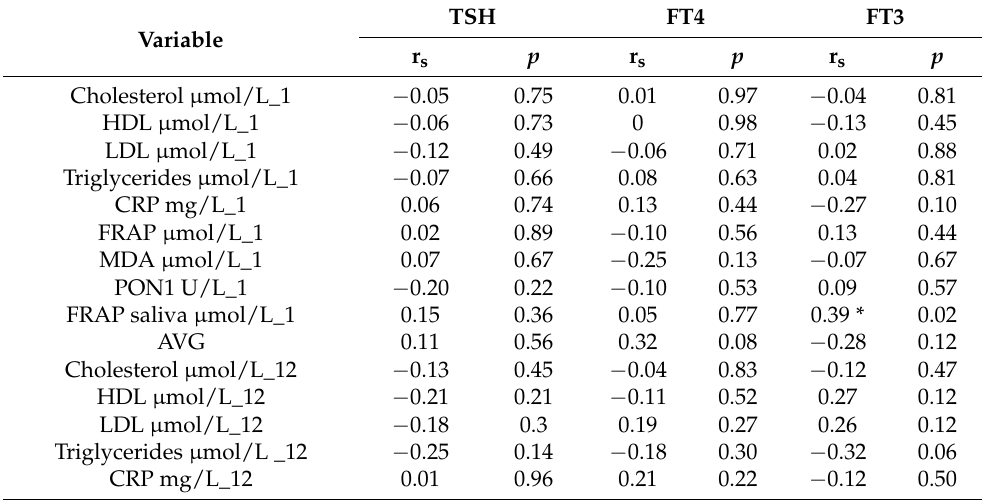
Table 4. Relationship of thyroid function assessment parameters with biochemical, routine specialized parameters and